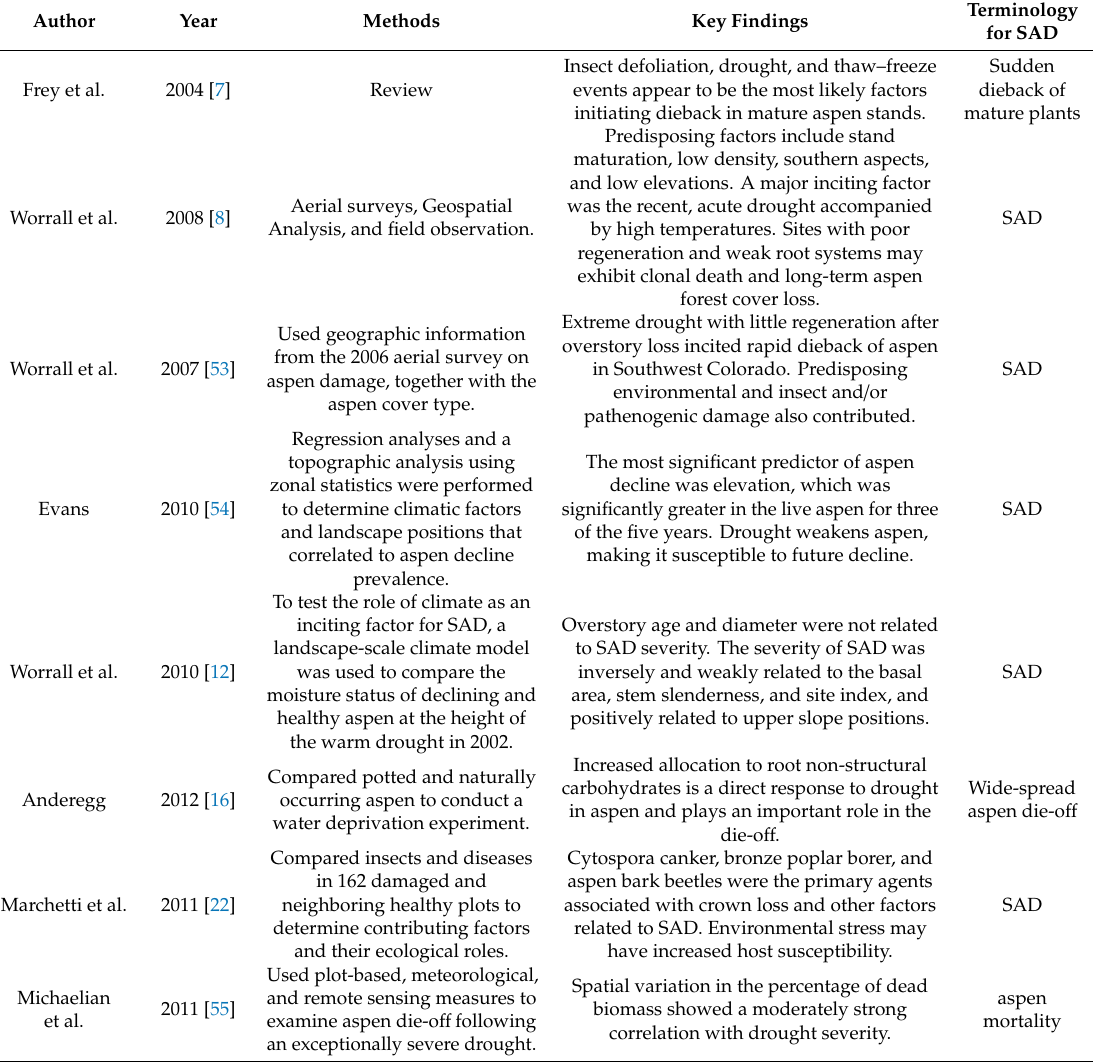
Table 2. Key studies that studied SAD. We examine their methods, key findings—which range from characterizing the disease to implementing management strategies—and the language used to discuss aspen die-o ff